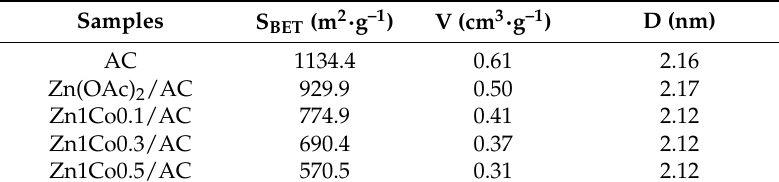
Table 1. The textural information of the catalysts.